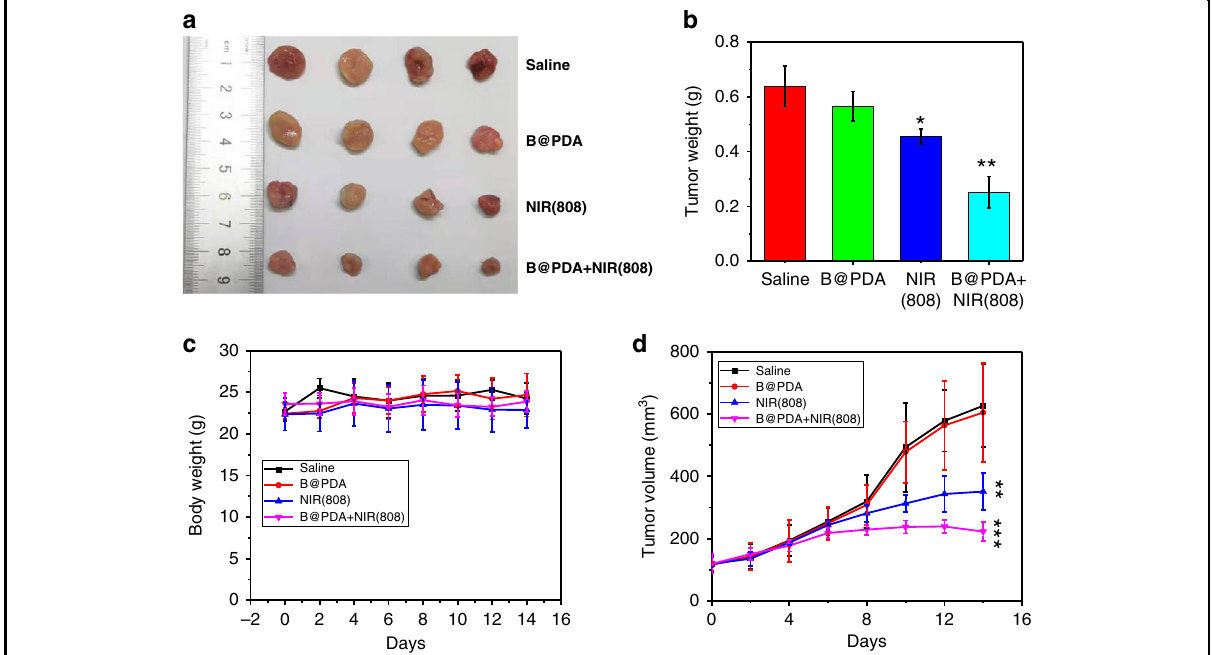
Fig. 10 In vivo photothermal therapy ef fi cacy of B@PDA platform. a Digital images of representative HCT-116 tumors after treatment. b Tumor weight comparison after treatment for four groups. c Tumor volume change during treatment ( n = 4). d Mouse weight change during treatment. Error bar and mean value are de fi ned as s.d. and mean, respectively. P -value was calculated by two-tailed Student ’ s t test (*** P < 0.005, * P <